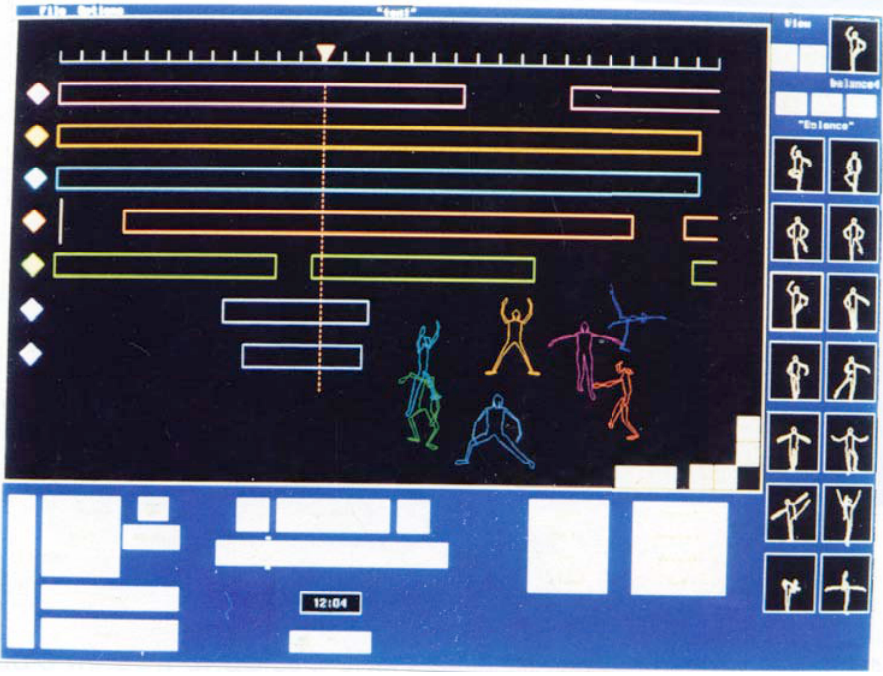
Figure 3.7 The Timeline View